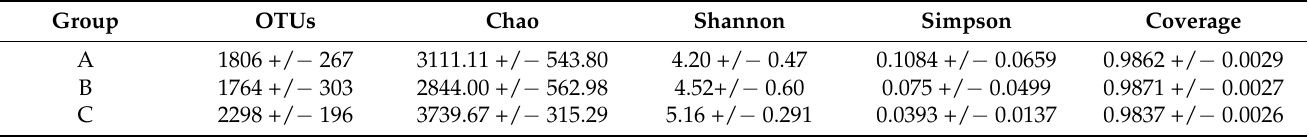
Table 2. Single sample diversity α -diversity analysis (mean +/ −